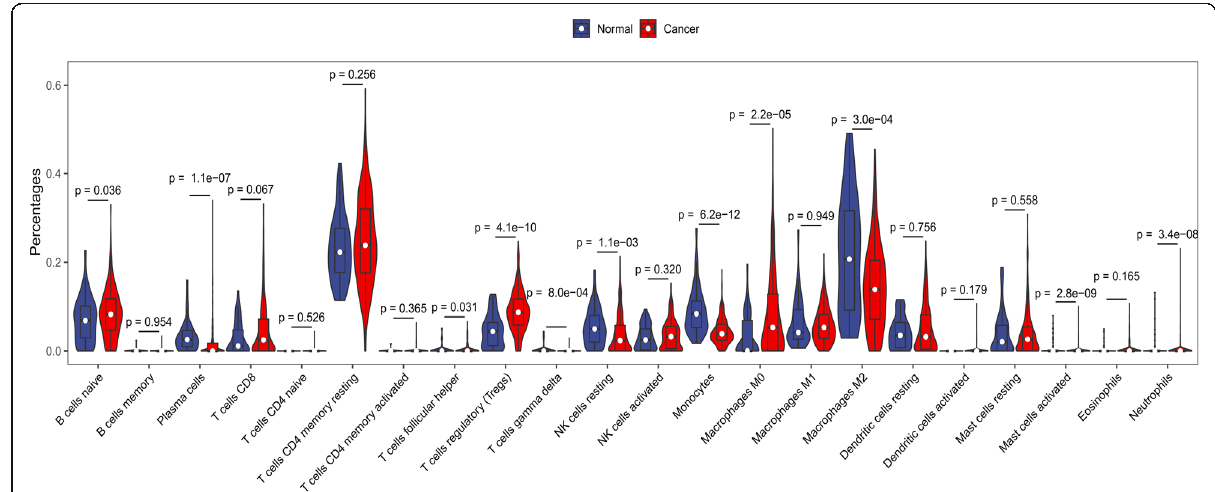
Fig. 1 Difference analysis in immune infiltration between the HCC samples and adjacent non-tumor samples. Normal and cancer indicate adjacent non-tumor samples and HCC samples, respectively. P < 0.05 was considered to indicate a statistically significant difference. HCC: hepatocellular